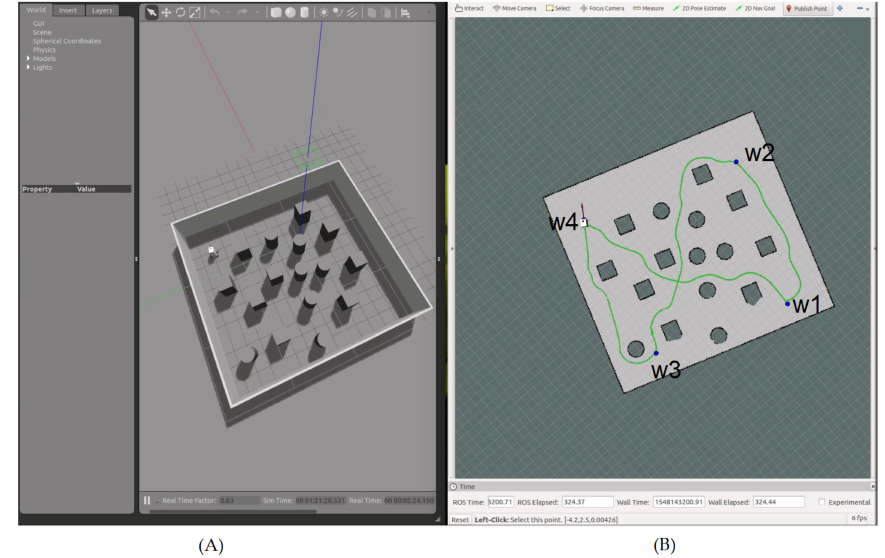
Figure 9. Simulation results showing the global navigation path of the robot, with the navigation area on Gazebo ( A ), and the simulated state of the robot on Rviz ( B ). The waypoints are enumerated according to their chronological order of selection. Every time the robot reaches a given waypoint, a new one is